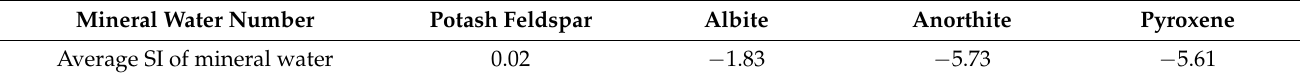
Table 2. SI values of mineral water samples for specific minerals. Mineral Water Number Albite Average SI of mineral